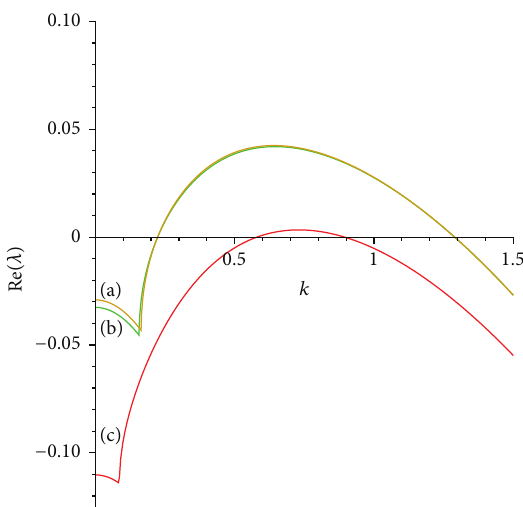
Figure 3: An illustration of model (24). We set the parameter values as (a) 𝛼 = 0 . 6, 𝛽 = 0 . 8, 𝛾 = − 0 . 3, 𝛿 = 0 . 58, 𝜃 = 2 . 2, 𝑑 1 = 0 . 08, 𝑑 2 = 1, and 𝜏 = 0 . 2; (b) 𝛼 = 0 . 6, 𝛽 = 0 . 8, 𝛾 = − 0 . 3, 𝛿 = 0 . 58, 𝜃 = 2 . 2, 𝑑 1 = 0 . 08, 𝑑 2 = 1, and 𝜏 = 0 . 02; (c) 𝛼 = 0 . 6, 𝛽 = 1 . 5, 𝛾 = − 0 . 3, 𝛿 = 1 . 1, 𝜃 = 2 . 2, = 0 . 05, 𝑑 = 1, and 𝜏 = 0 . 02 . 𝑑 1 2